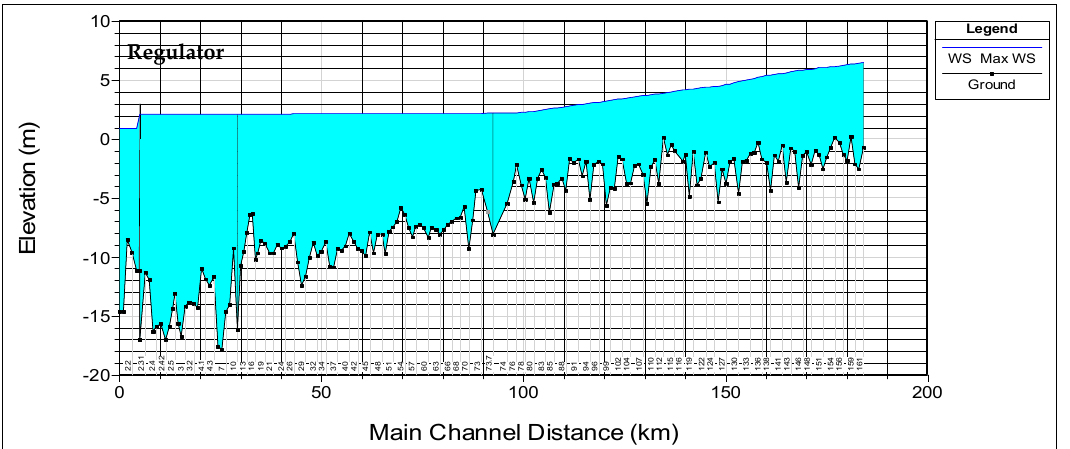
Figure 24. Water level profiles for the wave of maximum flow for case B1. Hydrology 2019 , 6 , x